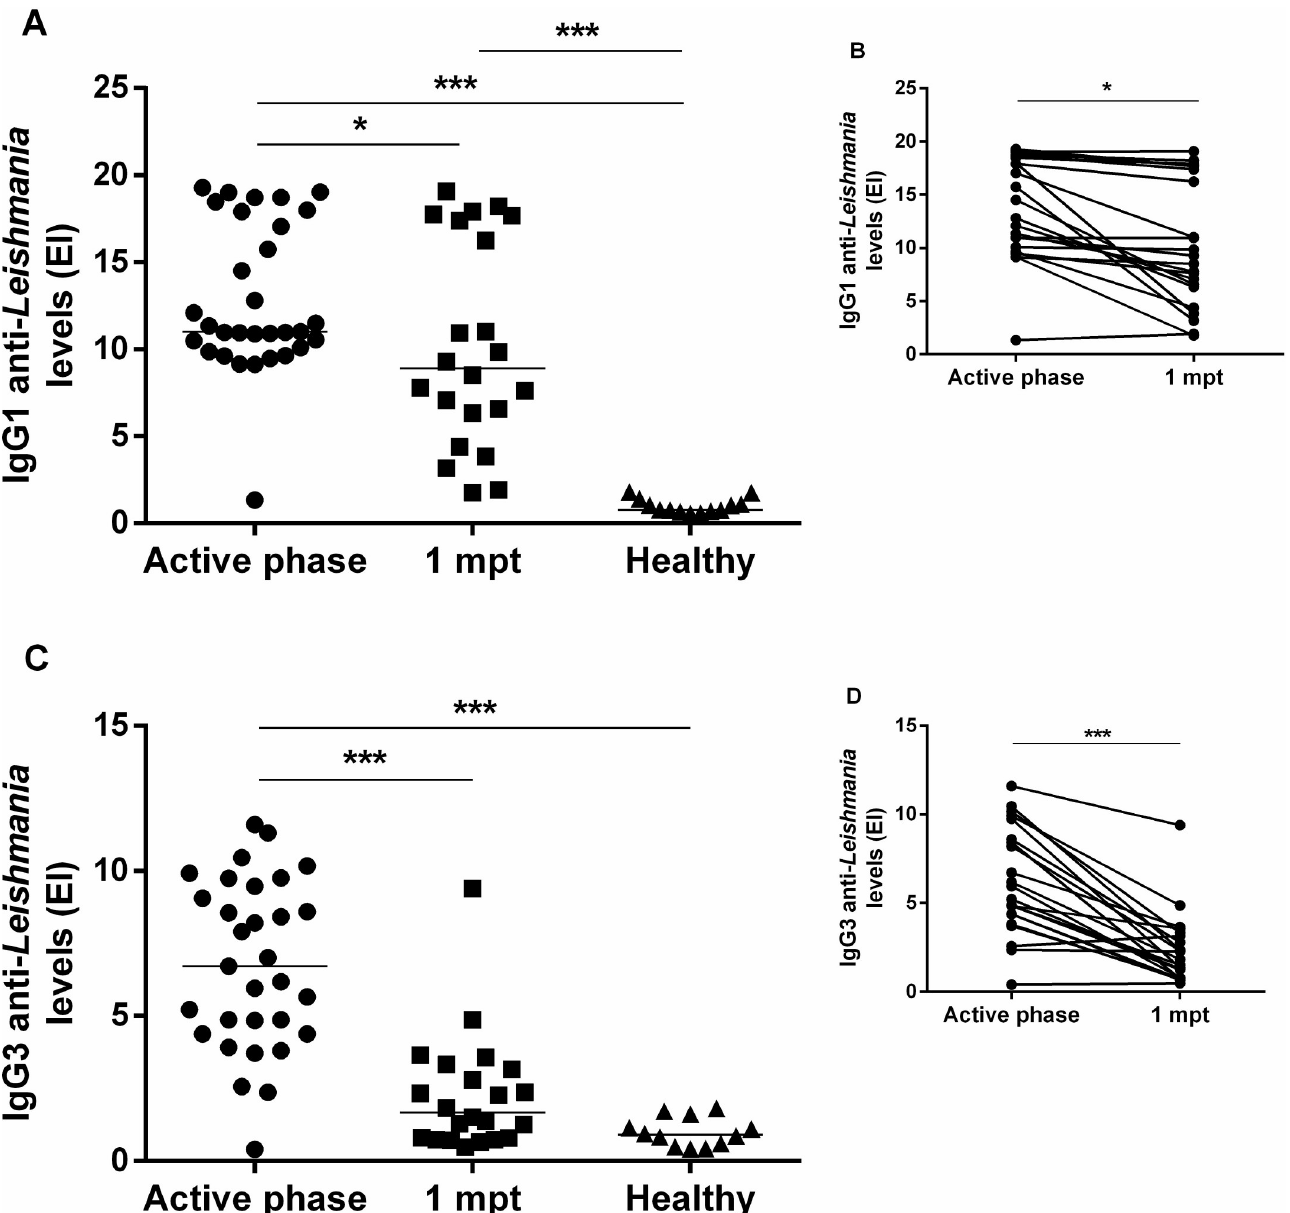
Fig 2. Titers of the anti- Leishmania (L . ) infantum immunoglobulin G1 (IgG1) and IgG3 in visceral leishmaniasis (VL) patients during clinical follow up. (A and C) IgG1 and IgG3 levels of VL patients in the active phase, after one-month post-treatment (1 mpt) and in healthy volunteers. (B and D) The insert shows the IgG1 and IgG3 levels from the same patients prospectively evaluated in two different time points (n = 22). Each symbol represents one patient. The horizontal bar represents the median values. Asterisks denote a statistically significant difference between groups, � p < 0.05; ��� p < 0.0001.